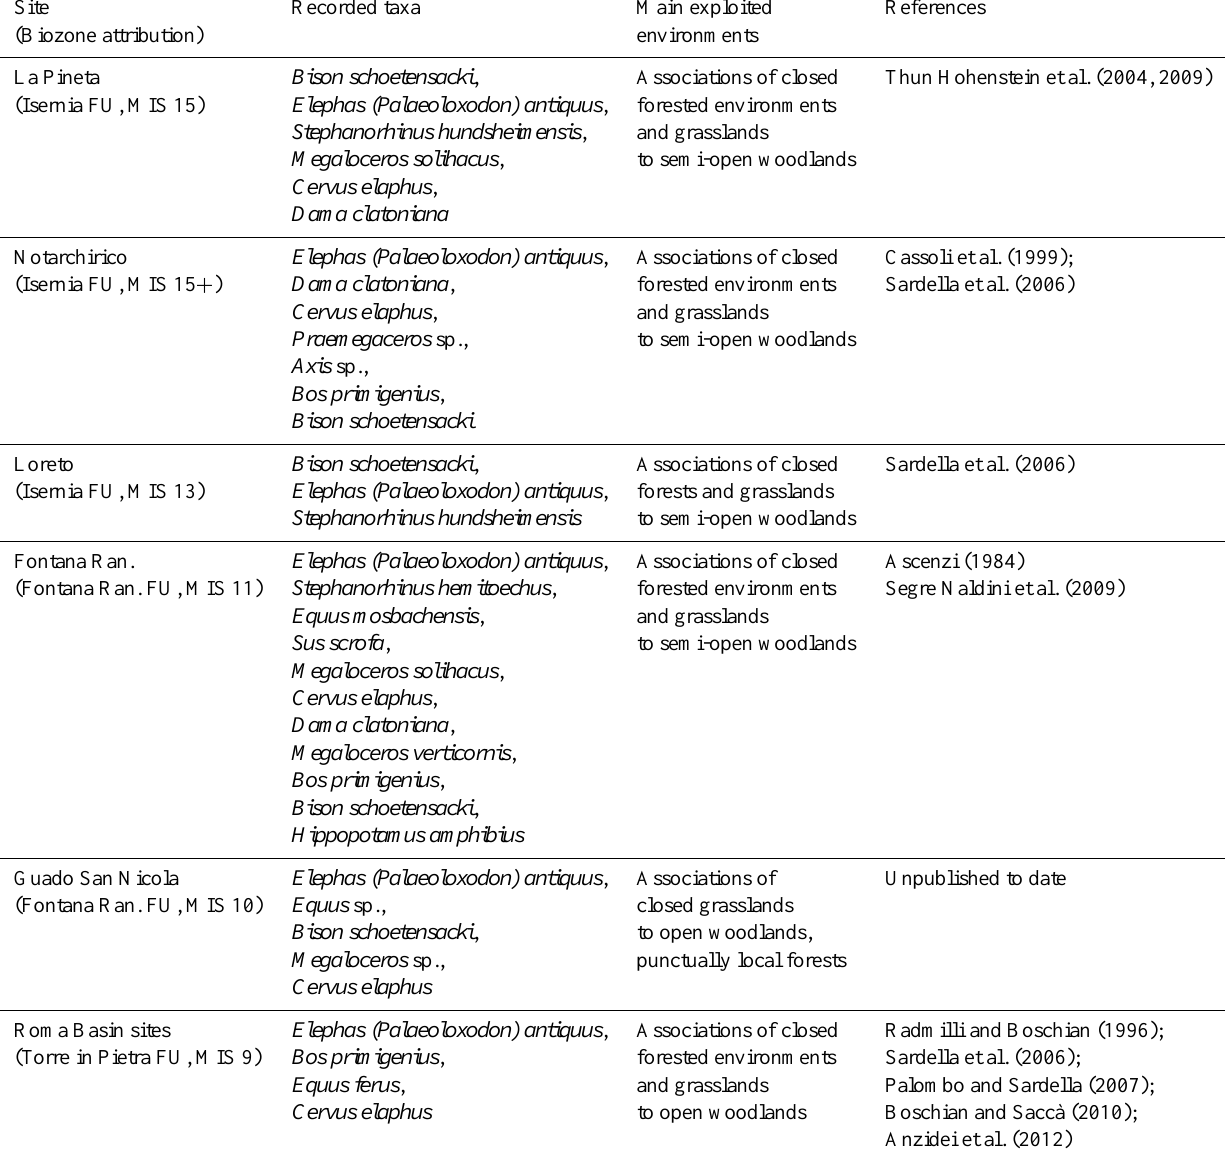
Table 2. Summary of the main taxa recorded on each studied site and the associated exploited